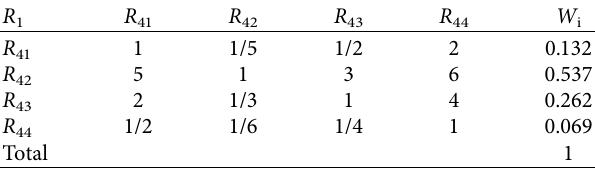
Table 7: Weight of teaching quality in second-level indicators.